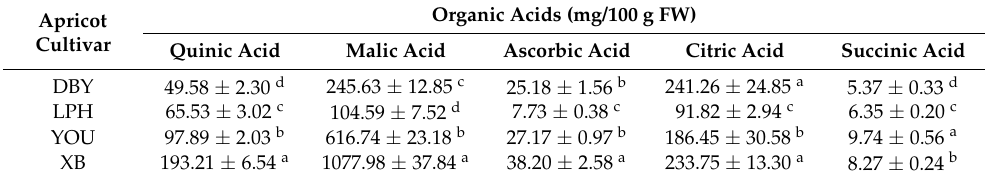
Table 3. The composition and content of organic acids in four different apricot cultivars. Apricot